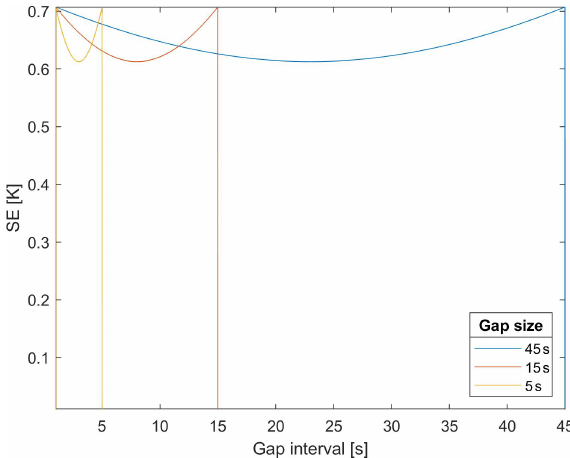
Figure 2. Linear interpolation standard error (SE), Eq. (8), as a function of the gap time for a white noise process with σ s = 0 .